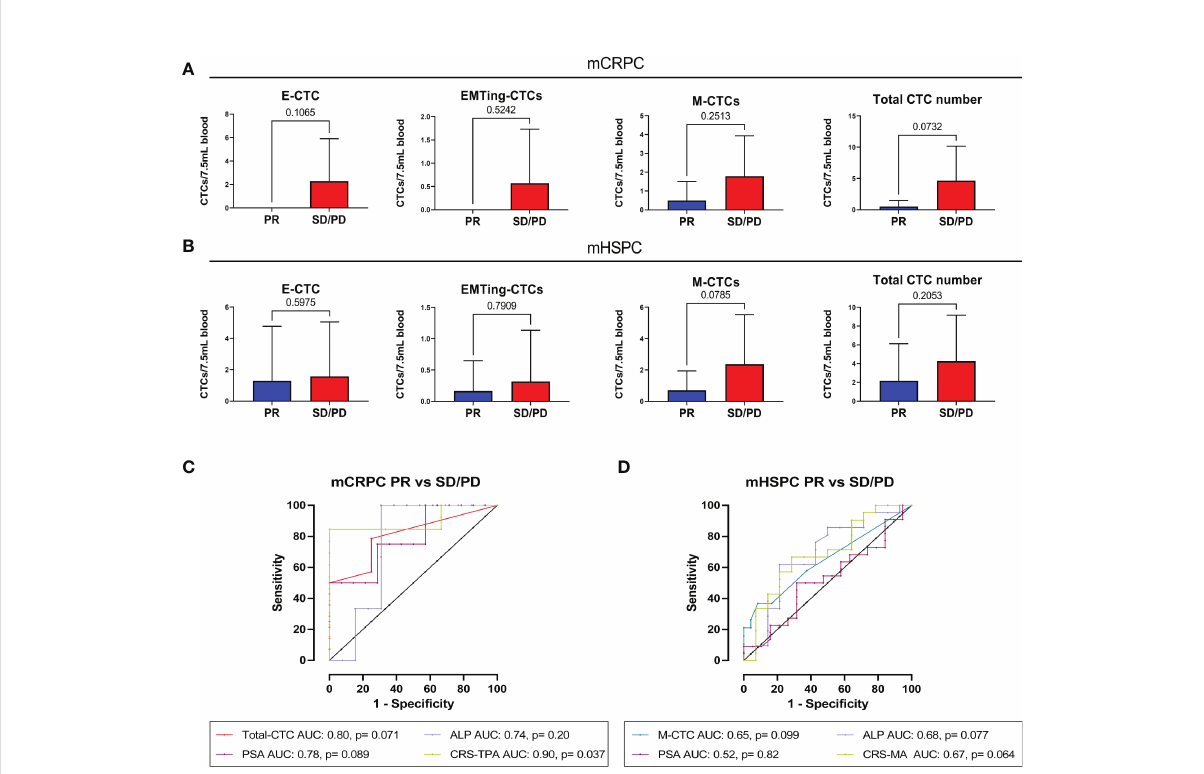
FIGURE 2 The relationship between pre-docetaxel CTCs and initial RECIST response. (A) Number of CTC subtypes and total-CTC numbers in mCRPC patients with PR or, SD and PD combined. Epithelial and EMTing-CTCs were not detected in patients with PR, although they did not signi fi cantly differentiate from patients with SD/PD, p=0.1065 and p=0.7907, respectively. Mesenchymal CTCs were detected in a small number of patients with PR but the majority were detected in patients with SD/PD (p=0.2513). Total CTC number trended towards a signi fi cant difference between patients with PR and SD/PD p=0.0732. (B) Number of CTC subtypes and total-CTC numbers in mHSPC patients with PR or, SD and PD combined. There was no signi fi cant difference in the numbers of epithelial-CTCs (p=0.5975), EMTing-CTCs (p=0.7909) and total-CTCs (p=0.2053) detected between patients with PR and SD/PD. However, mesenchymal-CTC numbers trended towards a signi fi cant difference between the patient outcome groups (p=0.0785). (C) For prediction of immediate tumour response in mCRPC patients, total-CTCs had an area under the curve (AUC) of 0.80, p= 0.071, PSA had an AUC of 0.78, p= 0.089 and ALP had an AUC of 0.74, p= 0.20. A combined risk score combining all three variables was calculated as CRS-TPA= 0.7414*Total-CTC number + 0.02909 *PSA + 0.01423*ALP, which increased the AUC to 0.90, p=0.037. (D) For prediction of immediate tumour response in mHSPC patients, mesenchymal-CTCs had that highest AUC of 0.65, p= 0.099, PSA had an AUC of 0.52, p= 0.82 and ALP an AUC of 0.68, p= 0.77. A combined risk score combining all mesenchymal CTC numbers and ALP was calculated as CRS-MA= 0.3599 * mesenchymal-CTC number + 0.002037 * ALP, resulted in an AUC of 0.69, p=